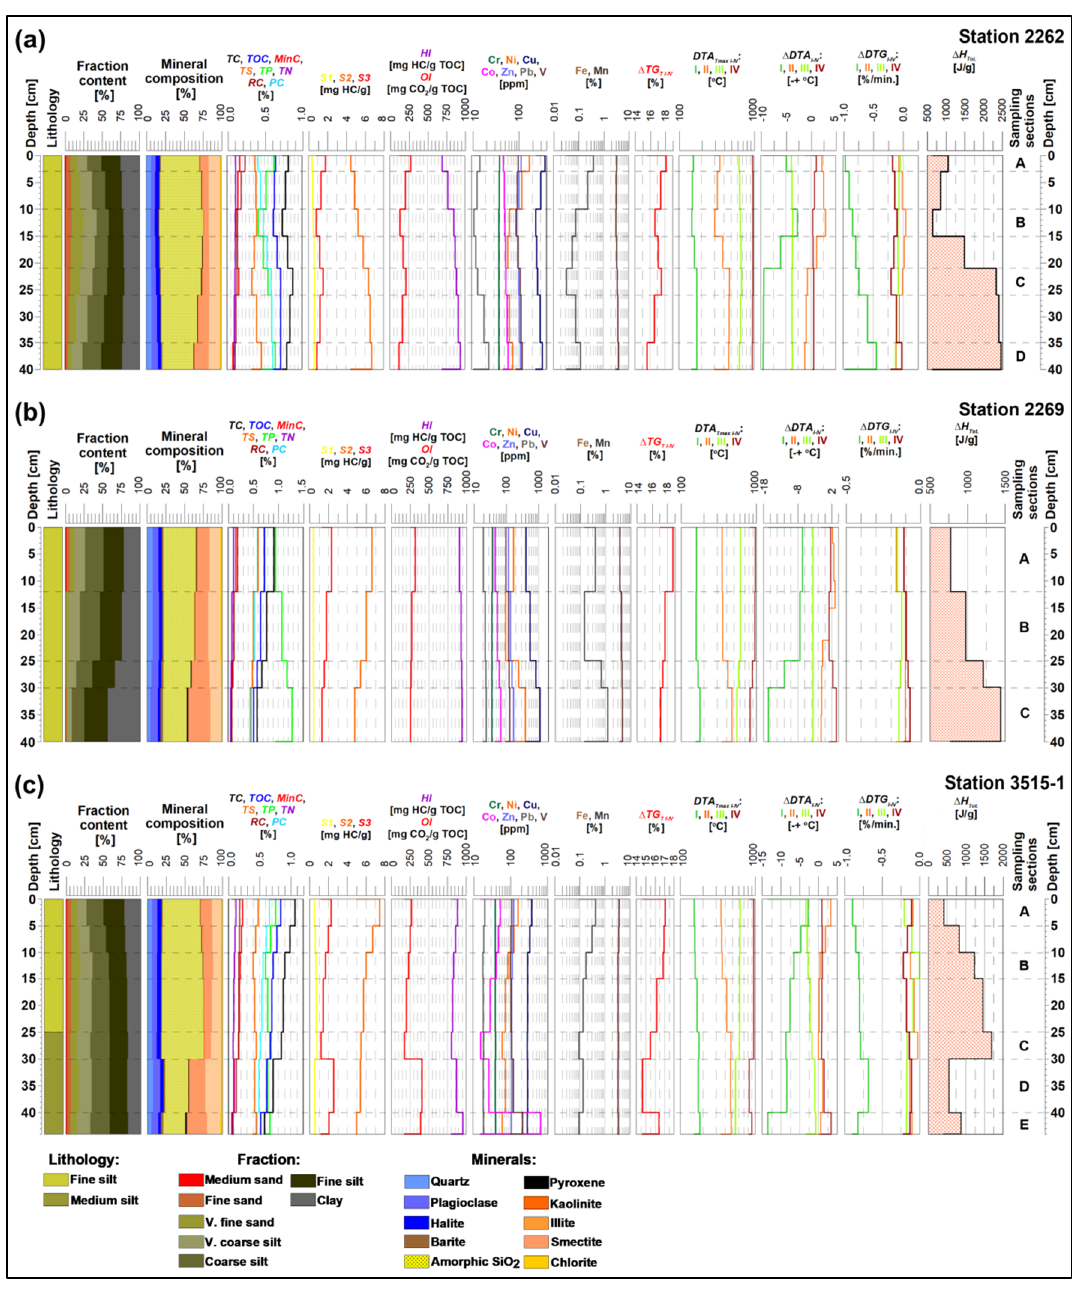
Figure 9. Representative lithogeochemical profiles of IOM stations 2262 ( a ), 2269 ( b ), and 3515-1 ( c ). Abbreviations of R–E6, thermal analysis (TA) parameters, and calculated indices are the same as in the main text (see Tables 2–4 and 6). Parameters of non-analysed sections were estimated and interpolated as an arithmetic mean.